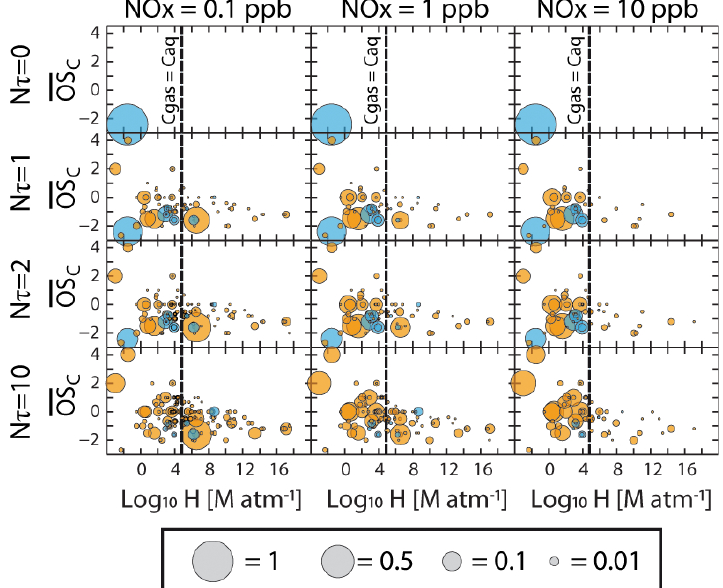
Fig. 6. Solubility and mean oxidation state of the species produced during the oxidation of isoprene under low NO x (1st column), intermediate NO x (2nd column) and high NO x (3rd column) conditions as a function of the number of precursor lifetime. Contribution of a species to the global carbon budget is proportional to the volume of the bubble. Position isomers having identical solubility and oxidation state are lumped in the same bubble. Blue bubbles denote species having the carbon skeleton of the parent hydrocarbon. Orange bubbles denote species with less carbon atoms than the parent compound. The black dashed lines denote the solubility for which a compound is equally distributed in the aqueous and gaseous